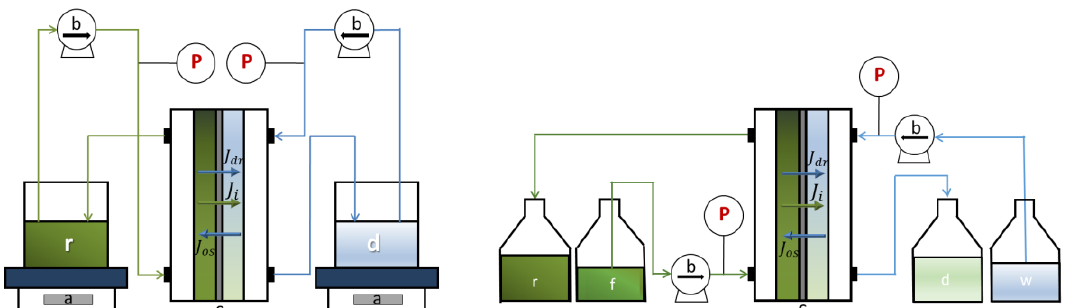
Figure 1. Sketch of the batch (on the left) and continuous (on the right) experimental systems. (a) balances, (b) peristaltic pumps, (c) Di ff usion Dialysis units, (r) retentate bu ff er, (d) di ff usate bu ff er, (f) feed tank, (w) deionized water tank, (P) pressure meter. The arrows denote the osmotic flux ( J os ), the drag flux ( J dr ) and the i -component flux ( J i ) across the membrane.